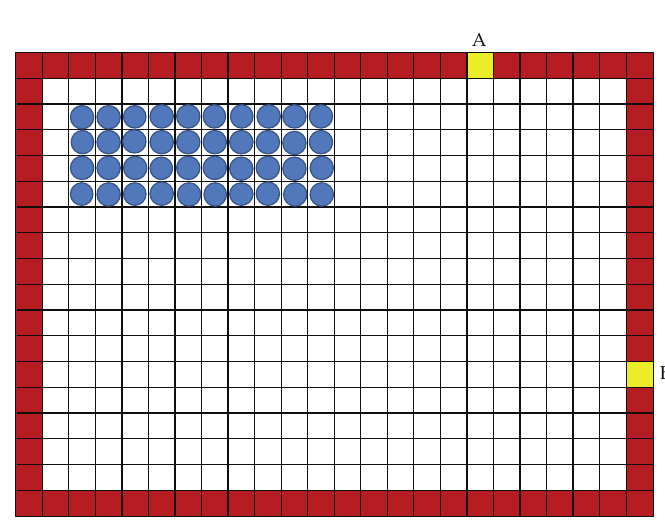
Figure 1: An 18 × 24 floor field with 40 pedestrians near the left side of exit A.